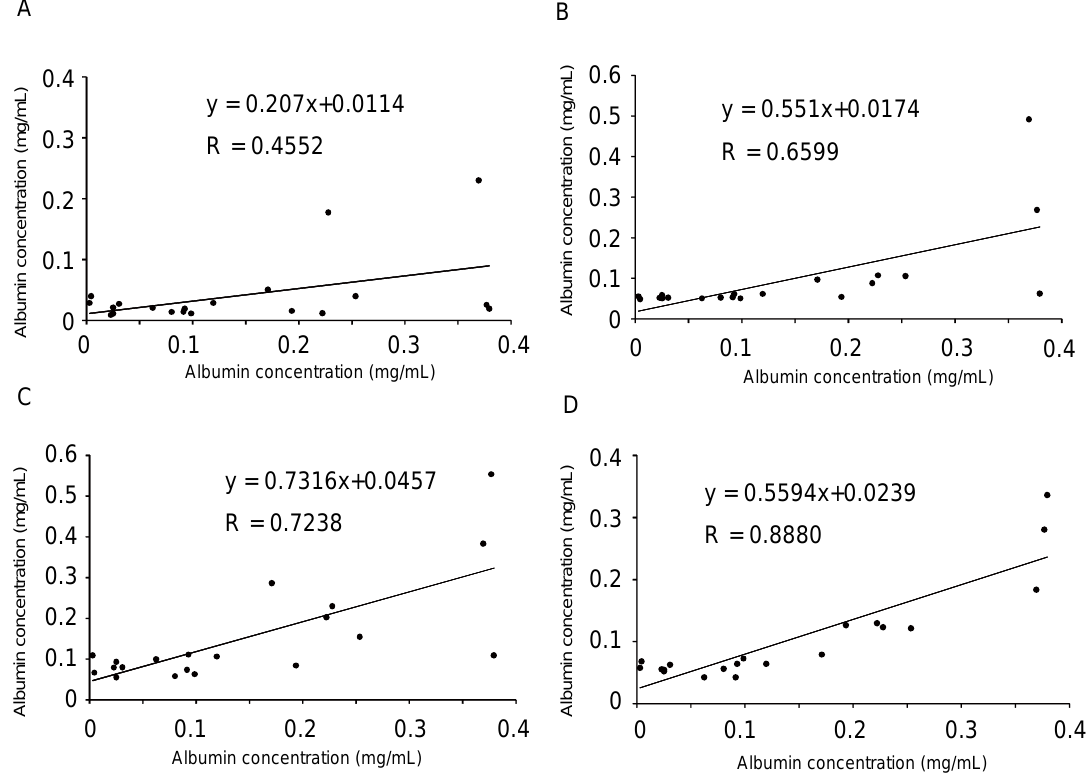
Figure 7. Comparison of albumin quantification results obtained from the immunoturbidimetric assay with those obtained using the albumin – luciferin reaction. Based on the values calculated in Figure 6, correlations were determined between ( A ) immunoturbidimetry versus the direct reaction of urine with luciferin, ( B ) immunoturbidimetry versus ammonium sulfate precipitation, ( C ) immunoturbidimetry versus PEG precipitation, and ( D ) immunoturbidimetry versus acetone precipitation. In each panel, the horizontal axis indicates the value of the immunoturbidimetric method. The approximate straight line and correlation coefficient were calculated.